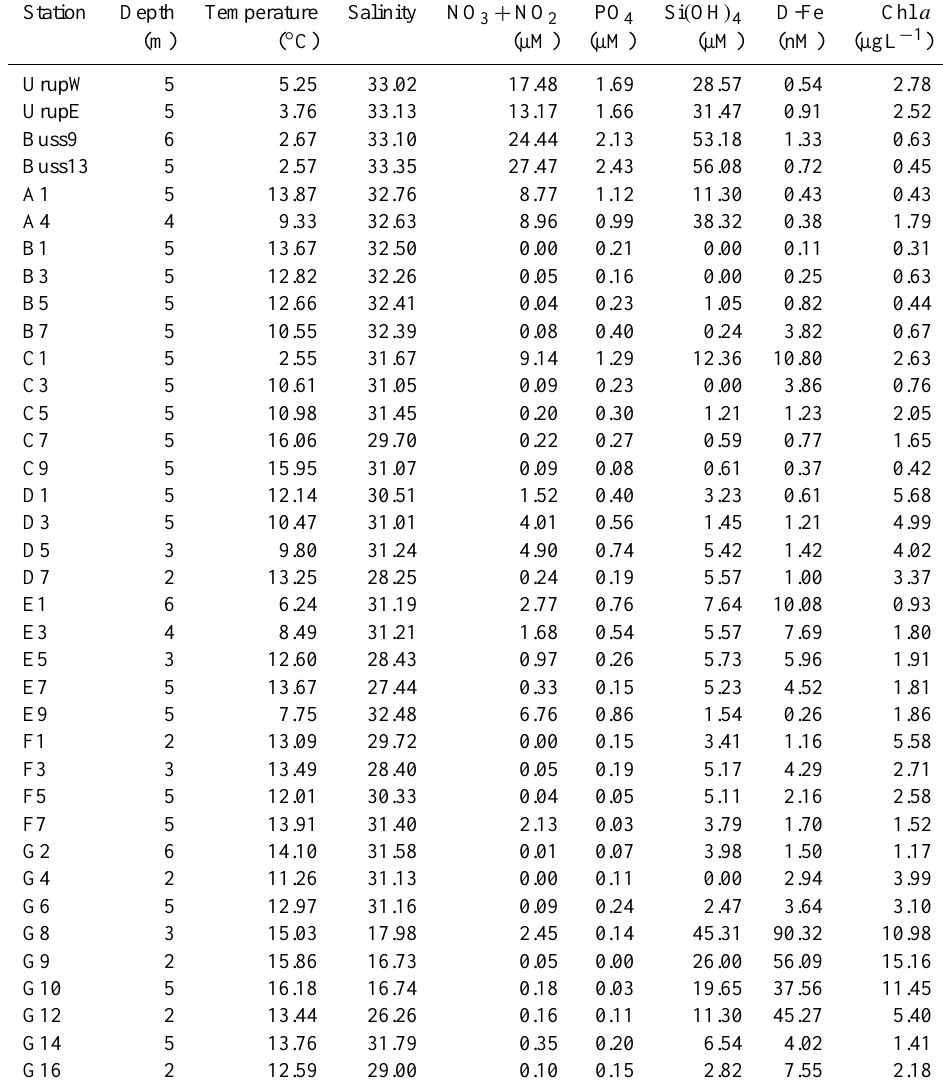
Table 1. Hydrographic properties in surface waters at each sampling station.